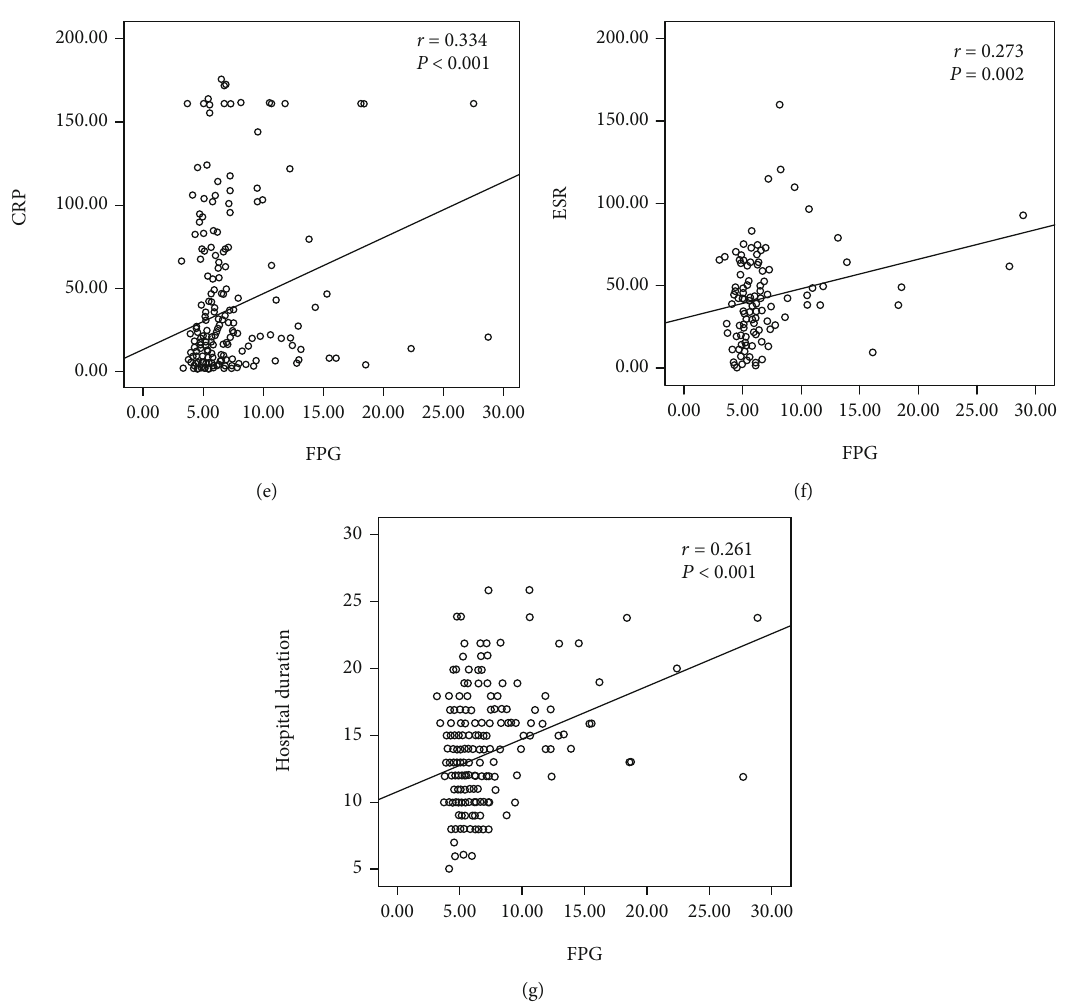
Figure 1: Correlations between the levels of in fl ammatory markers, hospitalization duration, and FPG levels from COVID-19 patients. (a, c, e, f, g) For all patients. (b, d) For the critical group. Spearman ’ s test was used to evaluate the correlation. WBC: white blood cell count; NLR: neutrophil to lymphocyte ratio; CRP: C-reactive protein; ESR: erythrocyte sedimentation rate; FPG: fasting plasma glucose; COVID-19: coronavirus disease